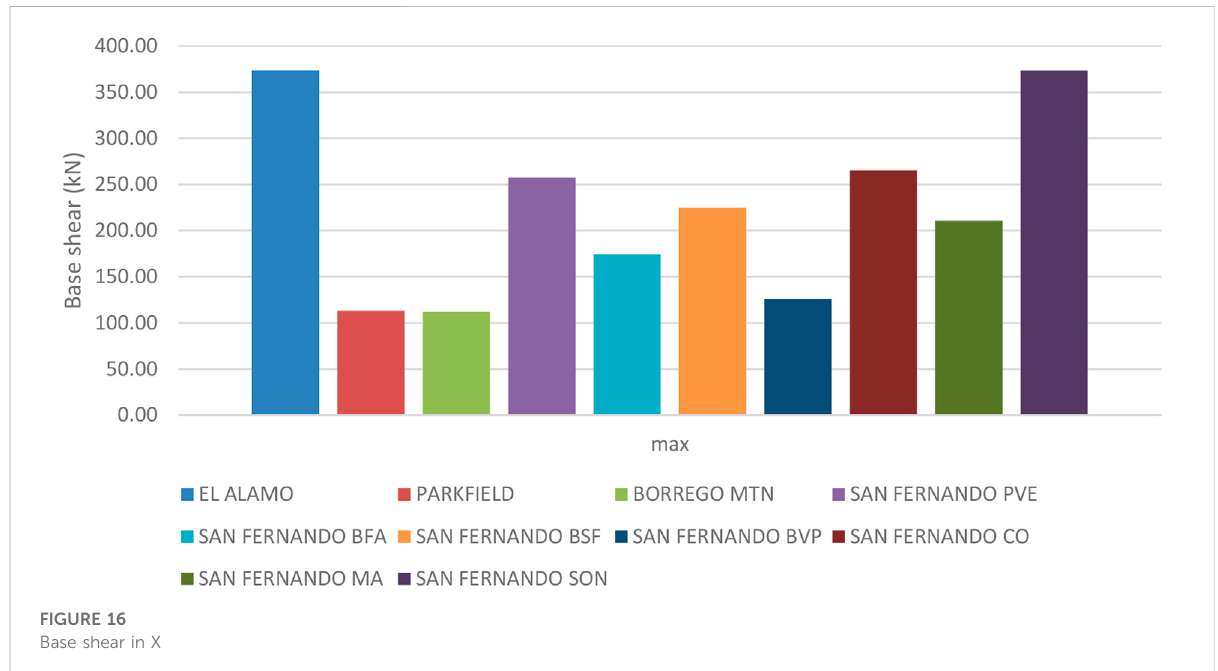
FIGURE 16 Base shear in X